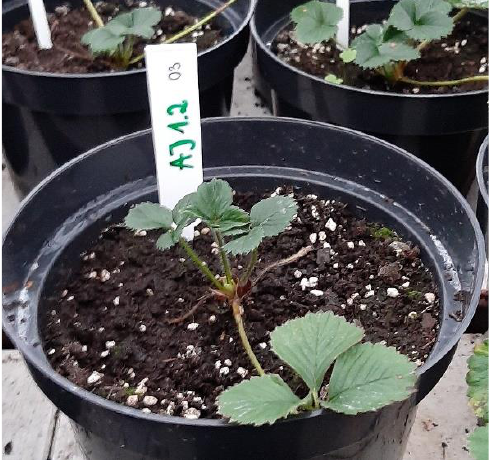
Figure 12. Strawberry cv. Polka at the time of